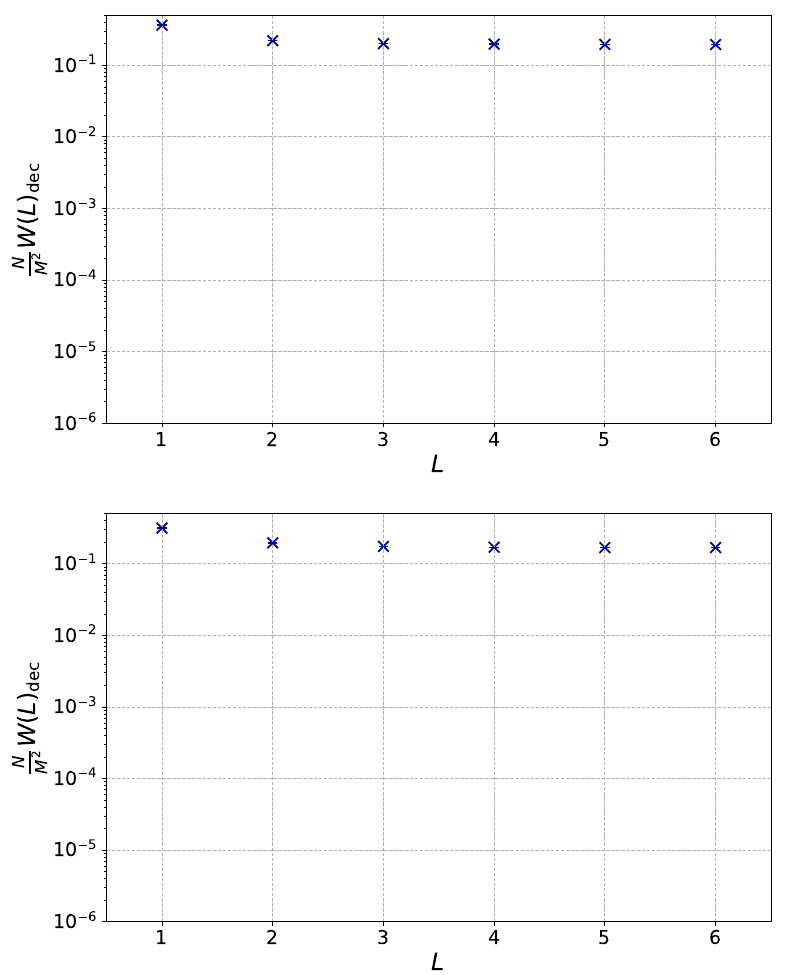
Figure 11. Deconfined subsector Wilson loop, W dec , at T = 0 . 29 , for P = 0 . 2 and P = 0 . 25 , respectively. We used the same scale as in figures 8, 9, and 10. The potential is clearly nonconfining, and no fitting was